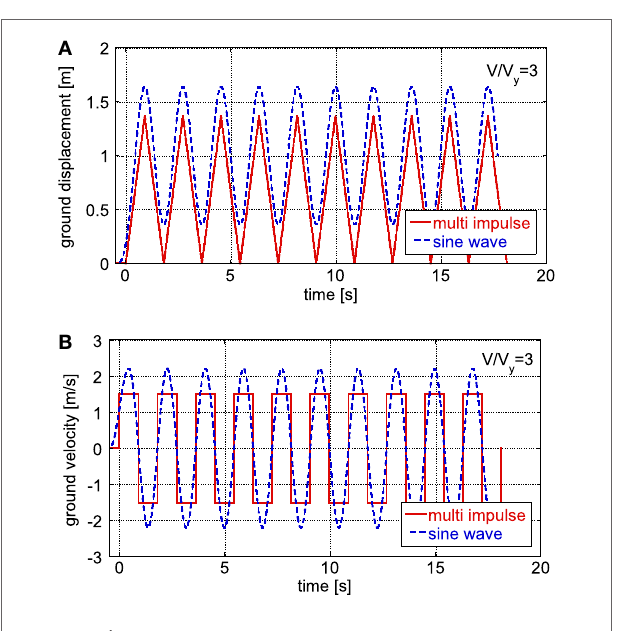
FigUre 12 | comparison of ground displacement and velocity between the multiple impulse and the corresponding multicycle sinusoidal wave for the input level V / V y = 3: (a) displacement, (B)